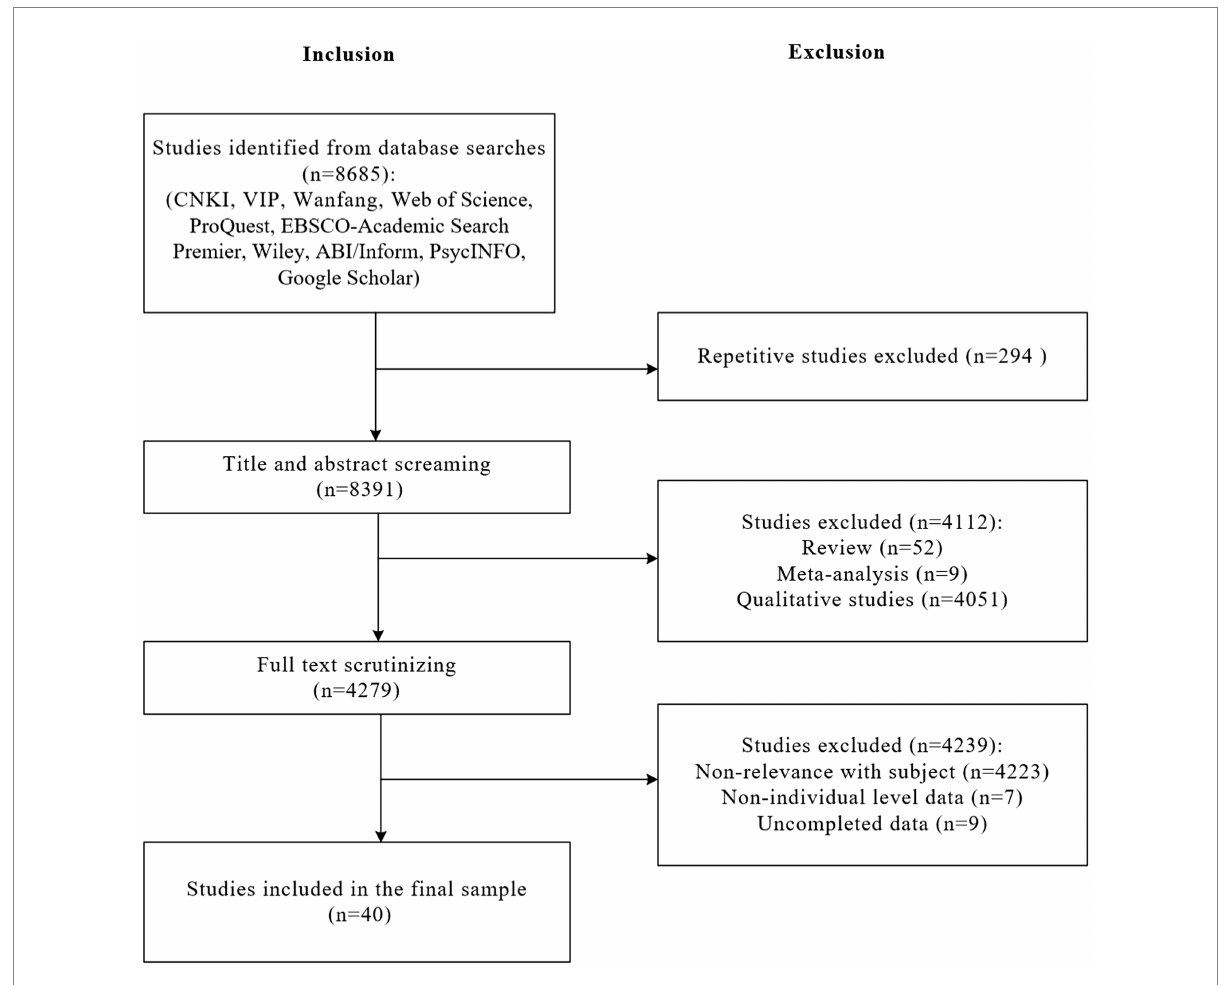
FIGURE 2 Literature search and inclusion